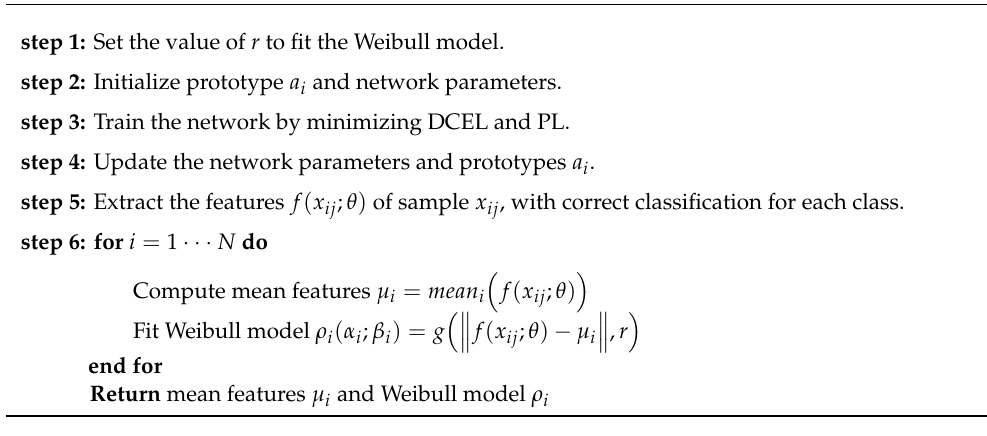
Algorithm 1 Training the network and fitting the Weibull